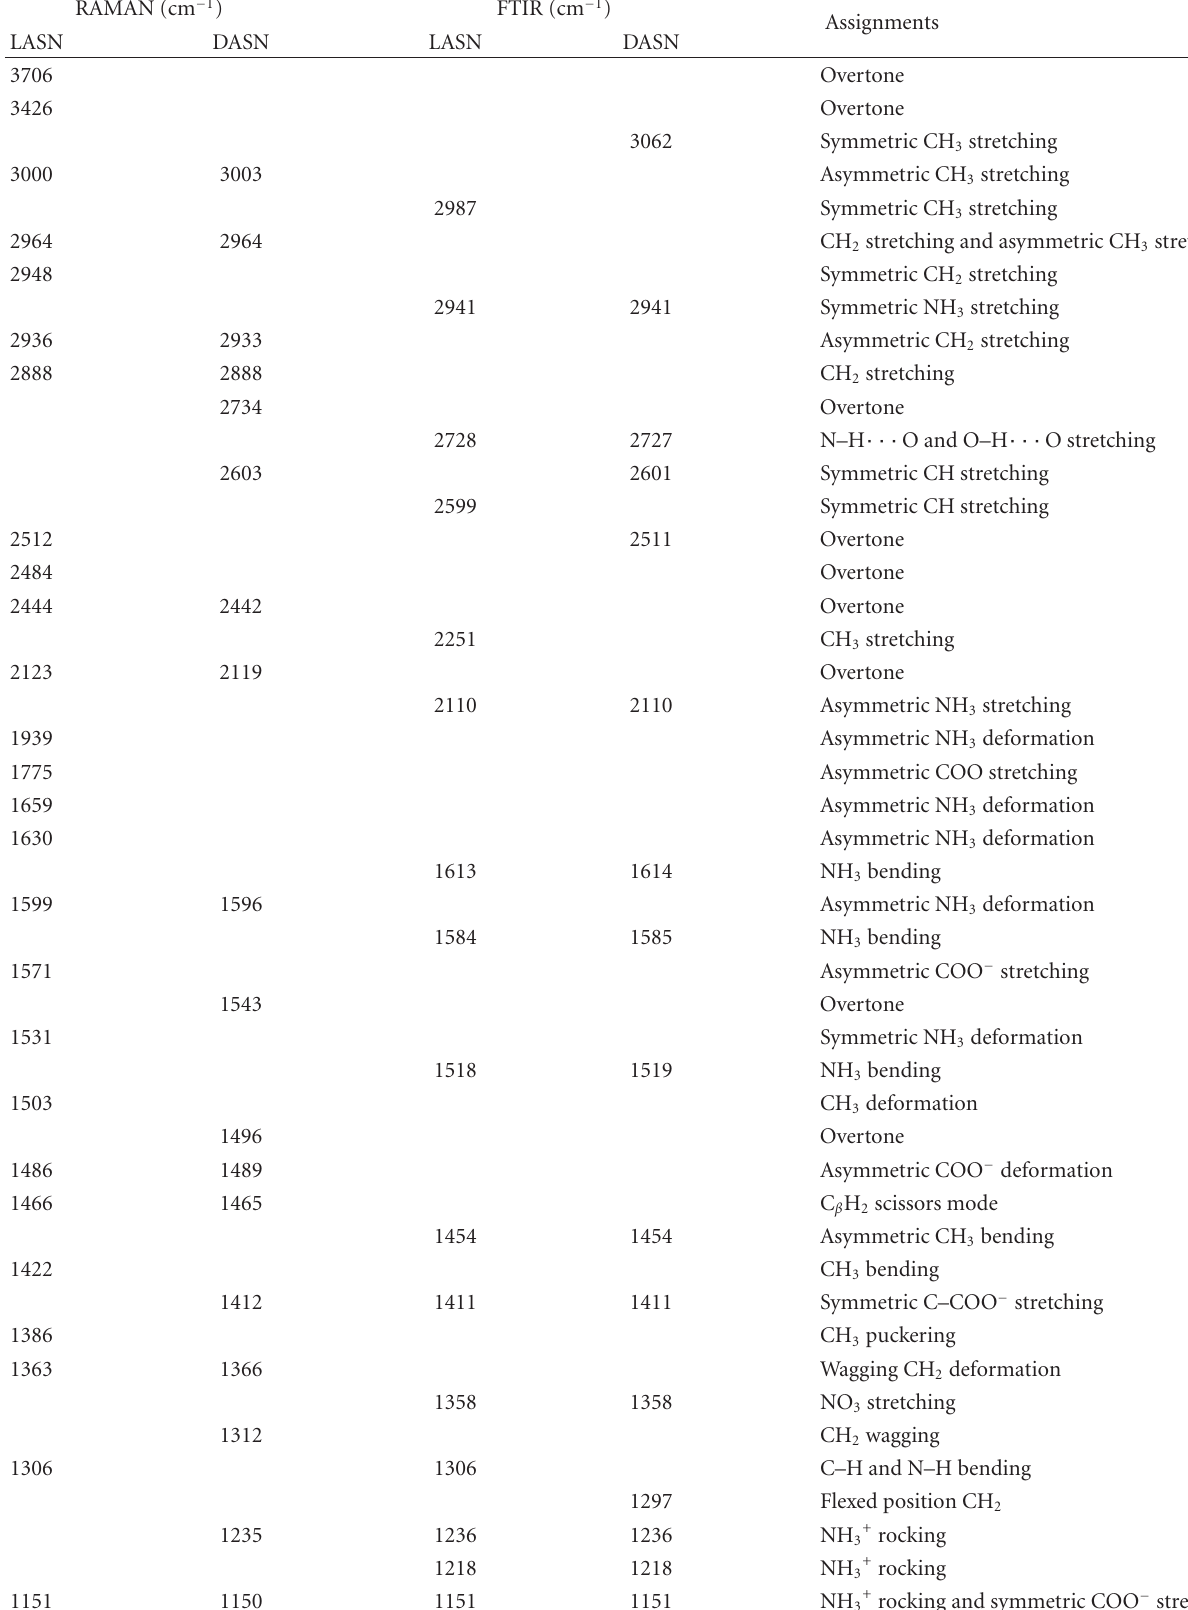
Table 1: FT-IR and Raman functional group assignments of the grown LASN and DASN. RAMAN (cm − 1